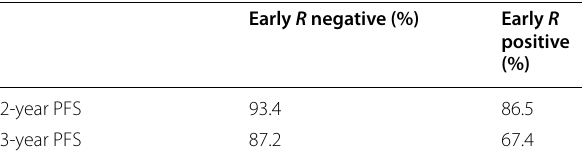
Table 7 PFS in DS interim negative and positive lymphoma